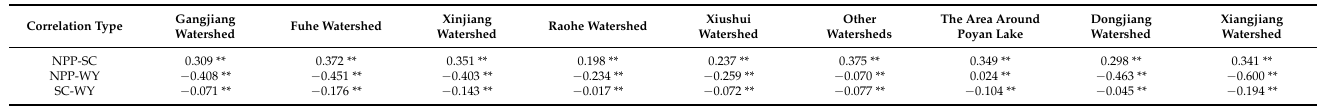
Table 3. Correlation Coefficient Between Three Ecosystem Services in Nine Watersheds in Jiangxi Province and Grid Scale.